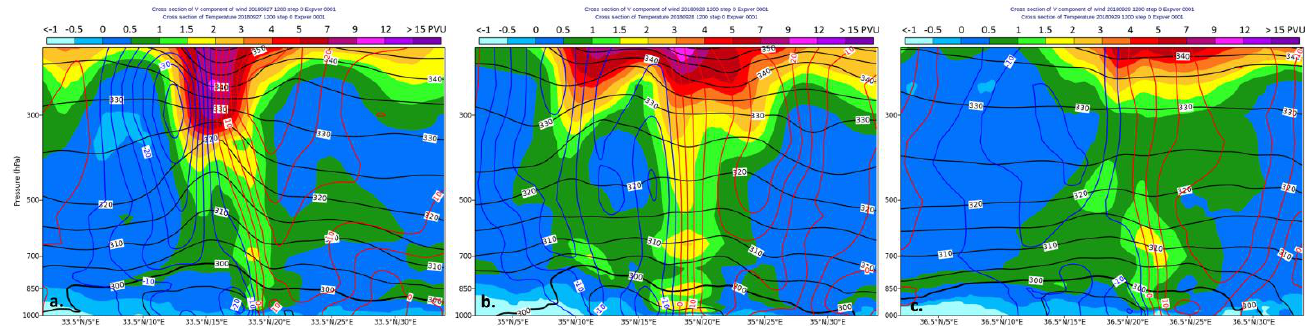
Figure 9. Longitudinal cross-sections of PV, potential temperature θ and meridional wind component following the cyclonic centre at ( a ) 27/12 UTC on 33.5° N, ( b )28/12 UTC on 35°N, and ( c ) 29/12 UTC on 36.5° N.